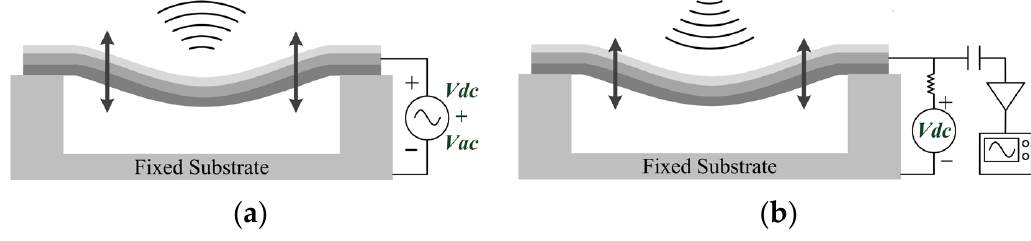
Figure 1. Working principles of a multilayer membrane capacitive micromachined ultrasonic transducer (CMUT) ( a ) as a transmitter; ( b ) as a receiver.